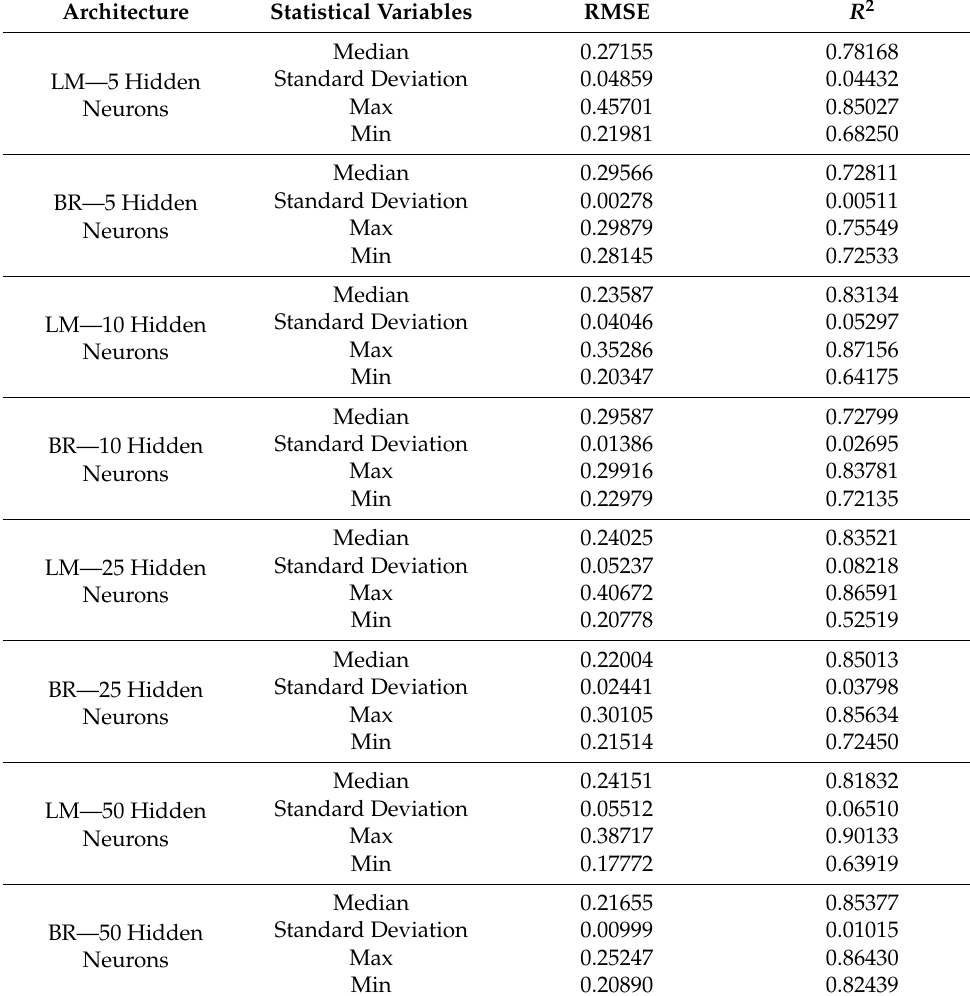
Table 4. Results summary for the structural FFNN2 with one hidden